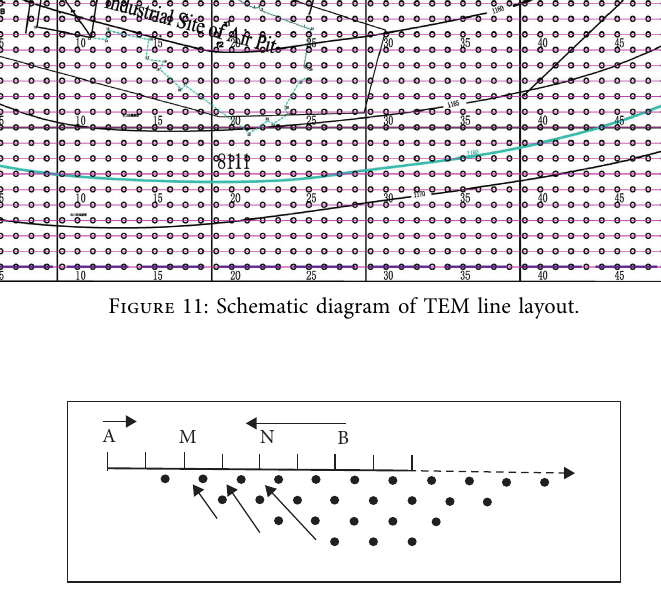
Figure 12: Schematic diagram of α arrangement.